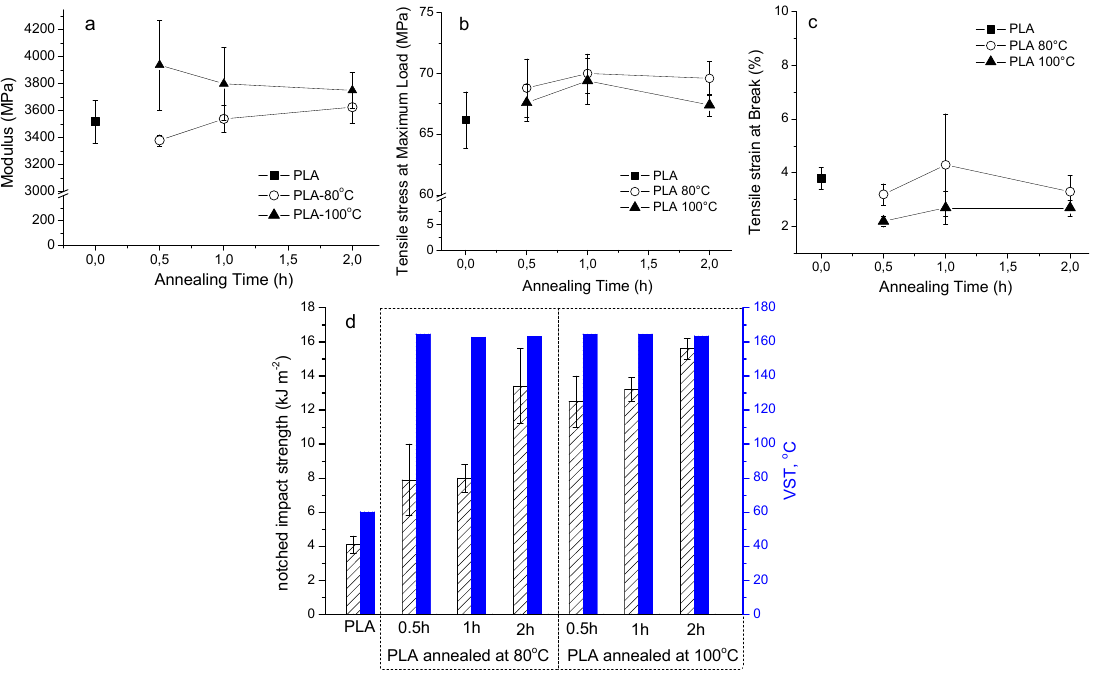
Figure 2. ( a ) Modulus, ( b ) Tensile stress at maximum load, ( c ) Tensile strain at break ( d ) Notched impact strength (grey bars) and VST (Vicat softening temperature) (blue bars) of PLA samples with and without annealing at 80 °C or 100 °C.